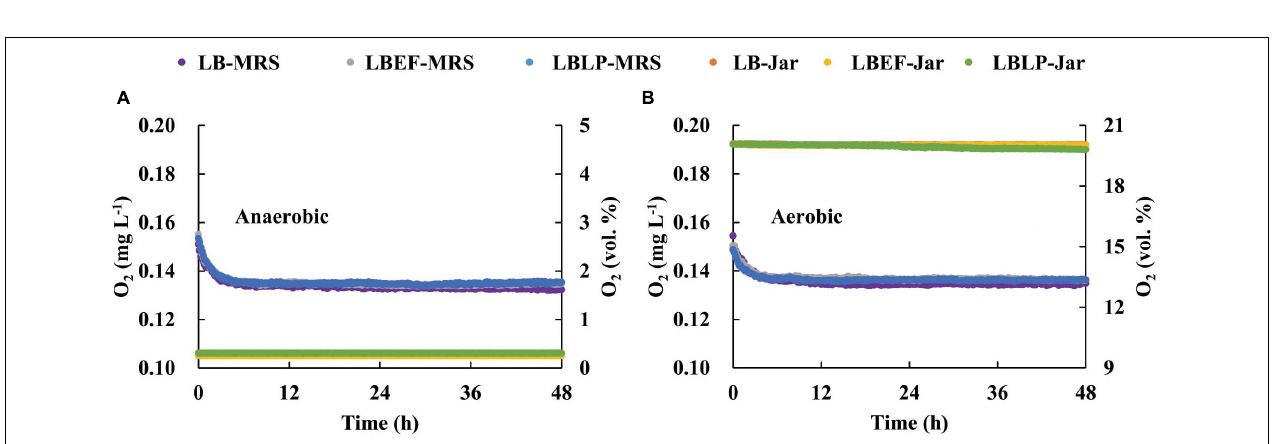
FIGURE 3 | Three time courses of the acidification process with respect to Lentilactobacillus buchneri (LB), LB mixed with Enterococcus faecium (LBEF), and LB mixed with Lactiplantibacillus plantarum (LBLP), under anaerobic (A) and aerobic conditions (B) . LB, Lentilactobacillus buchneri ; LBEF, LB mixed with Enterococcus faecium ; LBLP, LB mixed with Lactiplantibacillus plantarum .